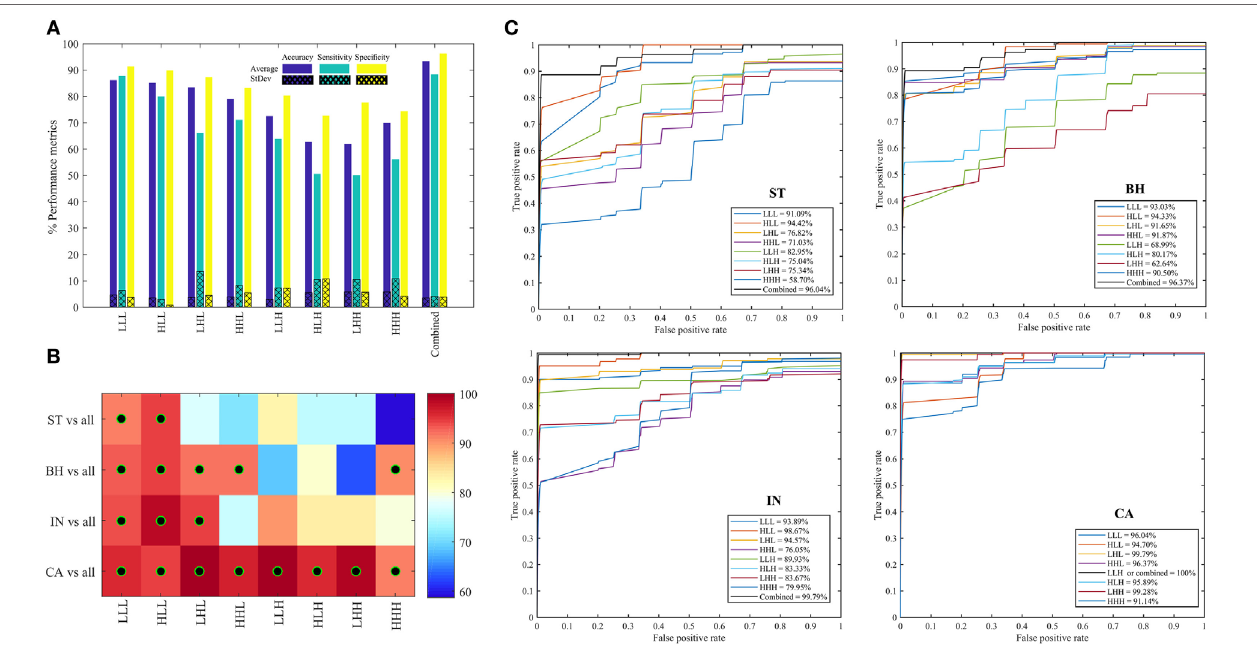
FigUre 6 | Performance metrics for classifying between stroma, benign hyperplasia, intraepithelial neoplasia, and carcinoma across eight oct-bands derived from 3D-wavelet transform. (a) Classifier rate (accuracy, sensitivity, and specificity). (B) Heatmap of area under the curve (AUC) values for pathology tissue (PT) in each oct-band, the black–green circle represents the AUC value greater than 90%. (c) ROC curves from each PT type across oct-bands.